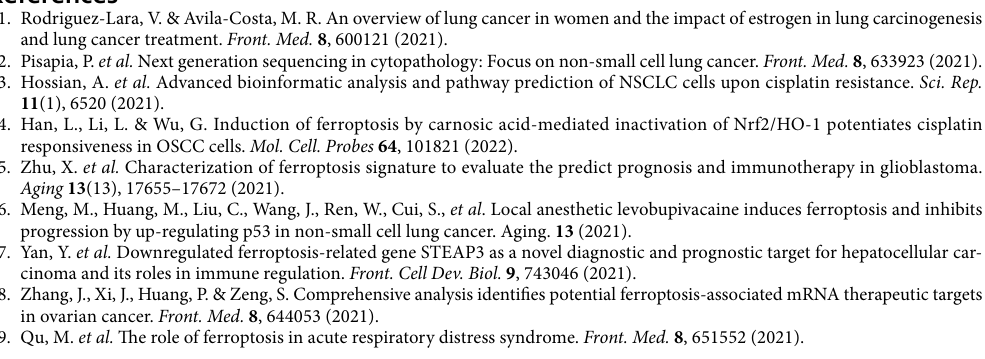
Figure 5. KDM1A-c-MYC axis conferred the resistance to ferroptosis in lung cancer cells. ( A , B ) The colony formation assay was performed in lung cancer cells H1299 and A549 with knockdown of KDM1A and c-Myc. ( C , D ) The cell viability assay was performed in lung cancer cells H1299 and A549 cells with knockdown of KDM1A and c-Myc. ( E , F ) Cellular Fe 2+ levels were detected in lung cancer cells H1299 and A549 with knockdown of KDM1A and c-Myc treated with erastin. ( G , H ) The MDA concentration was detected in lung cancer cells H1299 and A549 with knockdown of KDM1A and c-Myc treated with erastin. ( I , J ) The protein levels of HMOX1 were detected in lung cancer cells H1299 and A549 with knockdown of KDM1A and c-Myc. According to the molecular weight, the nitrocellulose membrane was cut prior to hybridization with antibodies and the original blots are presented in Supplementary Fig. 9. The graphs represent mean ± SD, two-tailed, Student’s t-test. N = 3, *p < 0.05; **p < 0.01; **p <